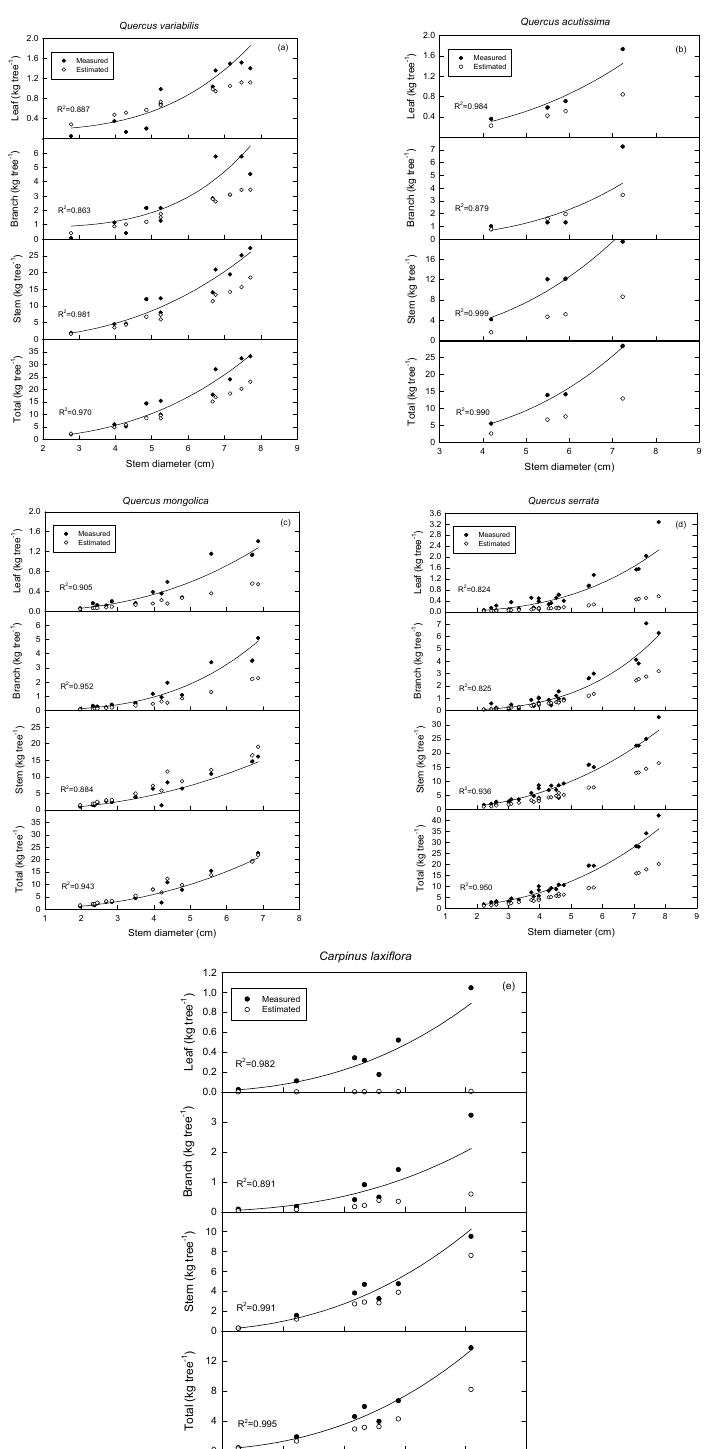
Figure 2. Measured and estimated allometric biomass of five species sampled in this study: ( a ), Quercus variabilis ; ( b ), Q. acutissima ; ( c ), Q. mongolica ; ( d ), Q. serrata ; ( e ), Carpinus laxiflora . Measured ( ● ) were made using samples of each species from Pinus rigida plantation. Estimated ( ○ ) were made using equations developed from Korea Forest Service [37]. Black line represents the calculating result of the biomass equation, log Y = a + b log D + c log H, that was developed in this study, where D is stem DBH, H is tree height, and Y is component dry weight.